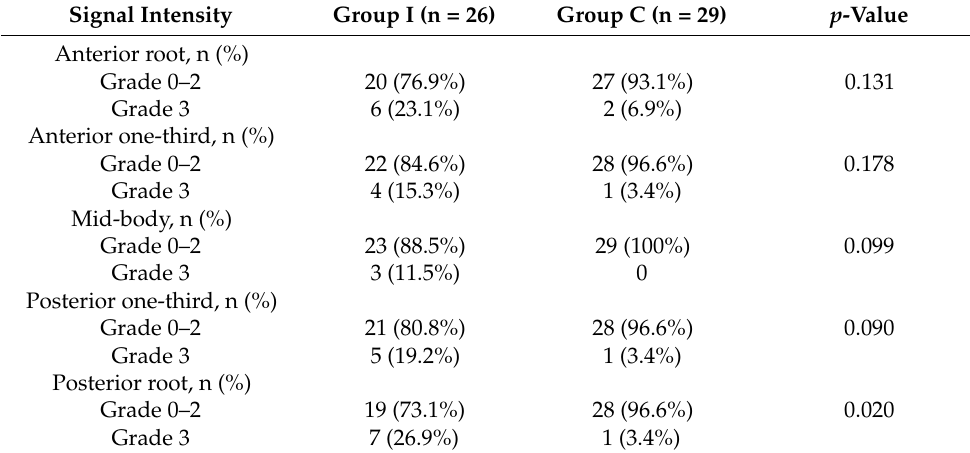
Figure 9. ( A ) Postoperative magnetic resonance image (MRI) at 2 days after lateral meniscal allograft transplantation (MAT) and ( B ) postoperative MRI at 1 year after the surgery in the patient who performed isolated lateral MAT. Graft extrusion increased from 0mm to 2.9mm. ( C ) Postoperative MRI at 2 days after lateral MAT and ( D ) postoperative MRI at 1 year after the surgery in the patient who performed lateral MAT + capsulodesis. Graft extrusion was not found until 1 year after the surgery. Table 3. Graft Signal on MRI at 1-year Table 2. Graft extrusion.